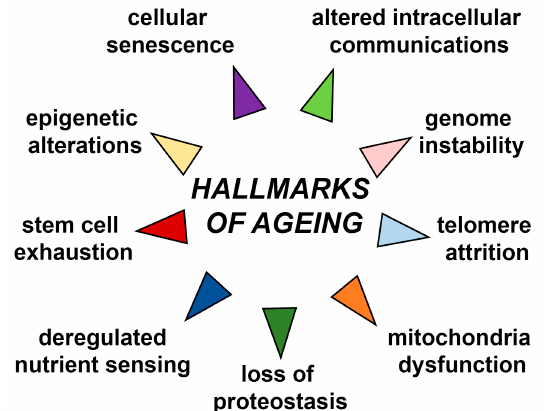
Figure 1. Schematic representation of nine major hallmarks of ageing. The scheme is based on the previously reported publication [2].